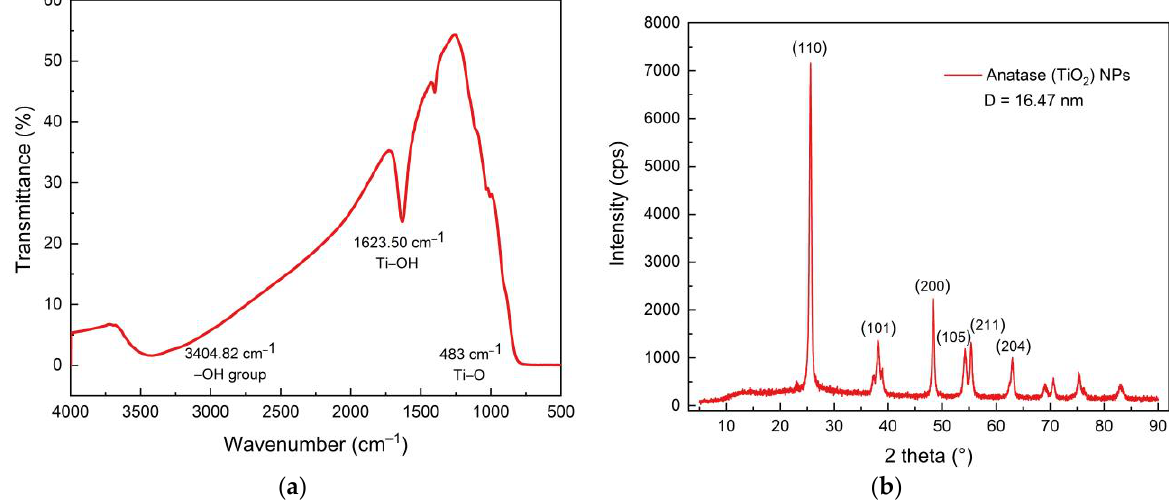
Figure 7. ( a ) FTIR spectra showing the vibration band of Ti-O at 483 cm −1 , and ( b ) diffractogram of the anatase phase of TiO 2 NPs used in this study.